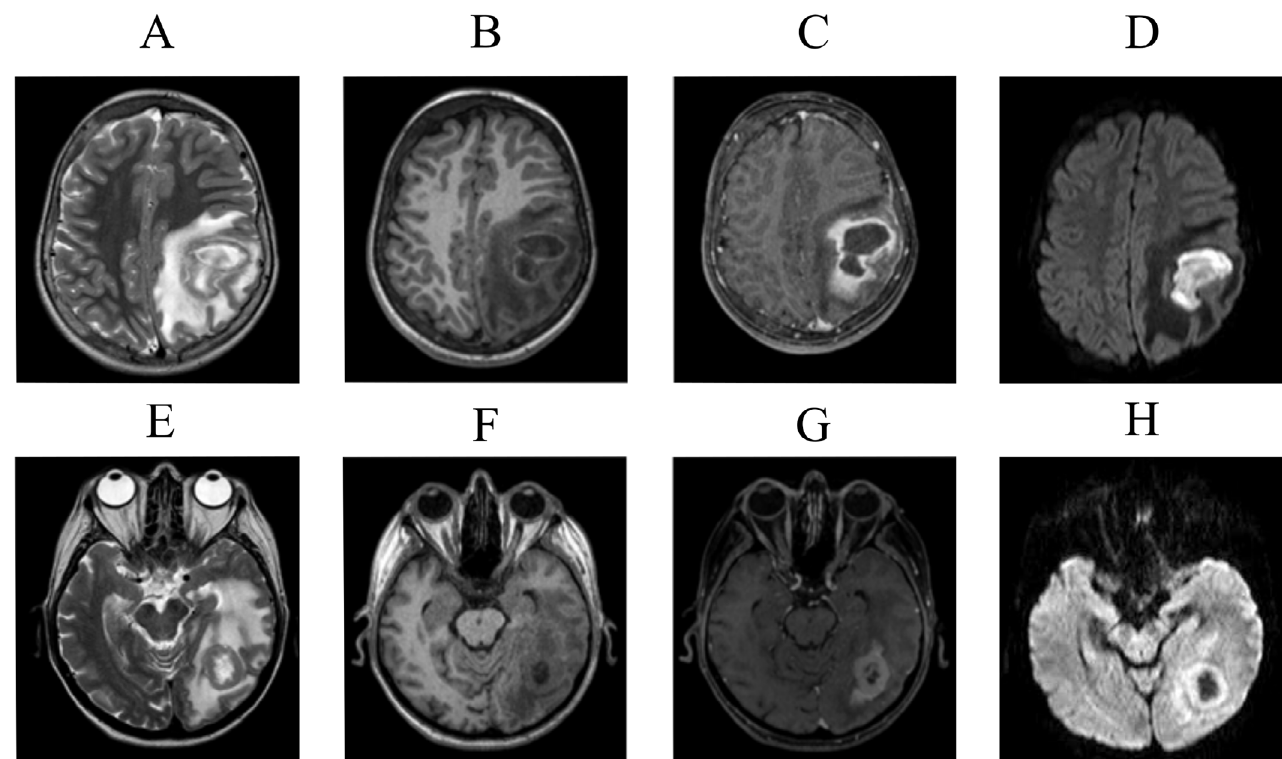
Figure 3. In upper images, a patient with pyogenic abscess, displayed with different MRI sequences. (A) T2-weighted images. (B) T1-weighted images without contrast. (C) T1-weighted images with gadolinium contrast medium. (D) DWI diffusion weighted images. In bottom images, a patient with a primary brain tumor, with the same MRI sequences. (E) T2-weighted images. (F) T1-weighted image with contrast. (G) T1-weighted image with gadolinium contrast medium. (H) DWI diffusion weighted image. Both have a pattern of a cerebral ring enhancing lesion. In abscess there is restricted diffusion in the core (D) a feature not demonstrated in the tumoral